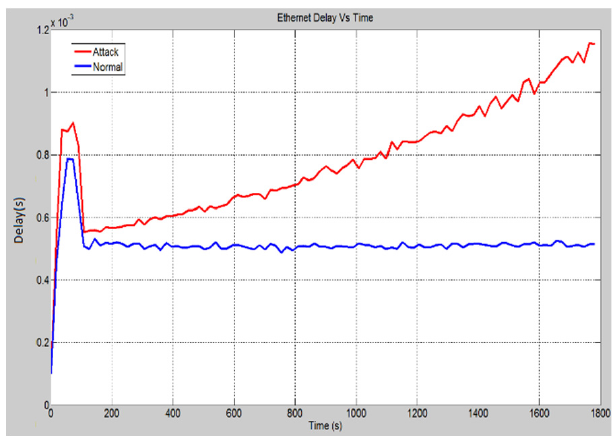
Figure 13. Global Ethernet delay (s) for the entire